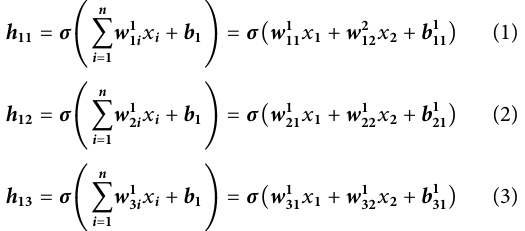
refers to X (cid:1) ( x 1 , x 2 ) , as the input data, and a vector with three elements, which refers to Y (cid:1) ( y 1 , y 2 ,y 3 ) , as the output data. “ Hidden layer ” is a hidden layer used to extract features.